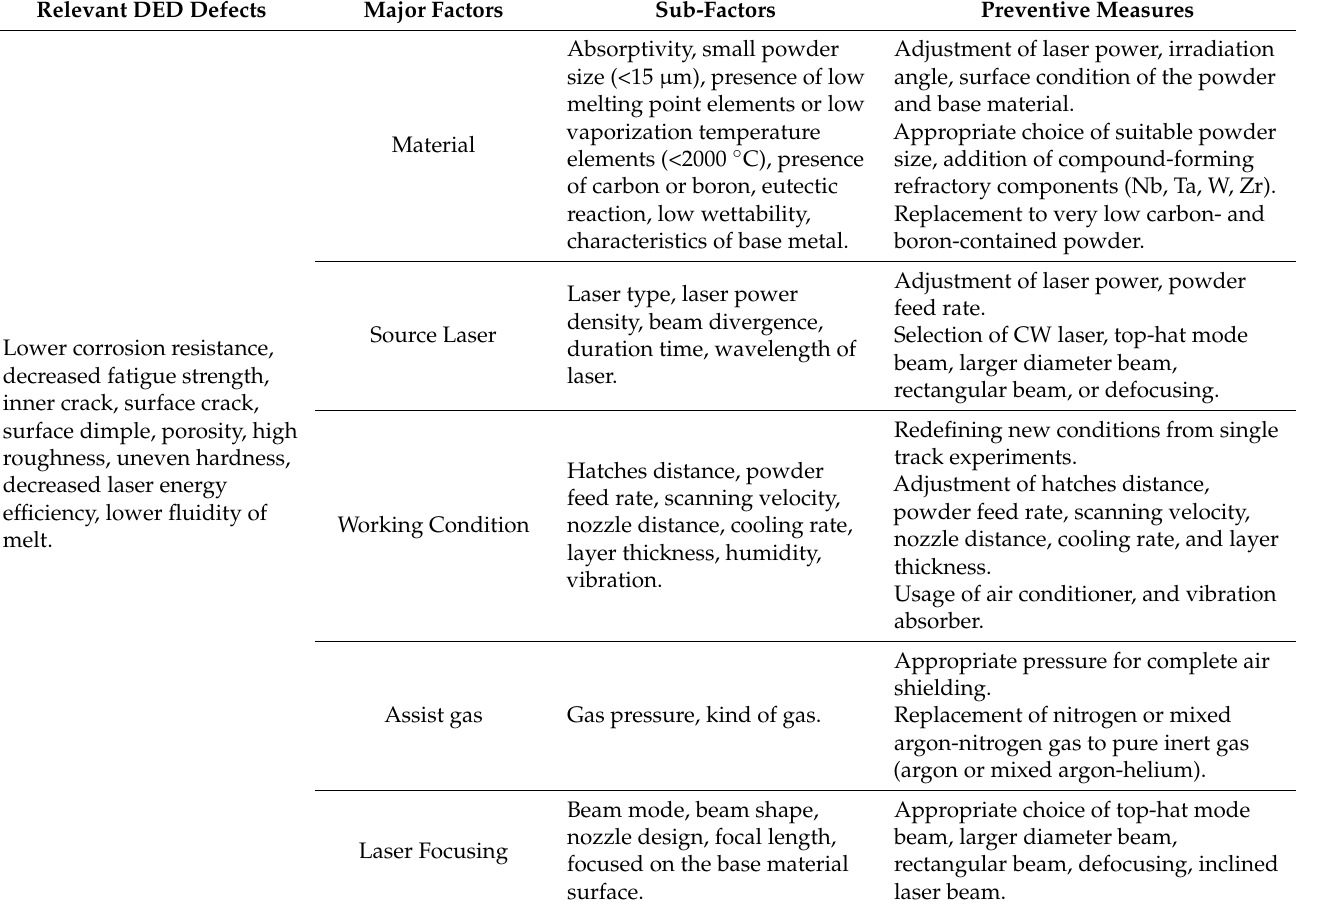
Table 1. Preventive methods of fume and spatter in